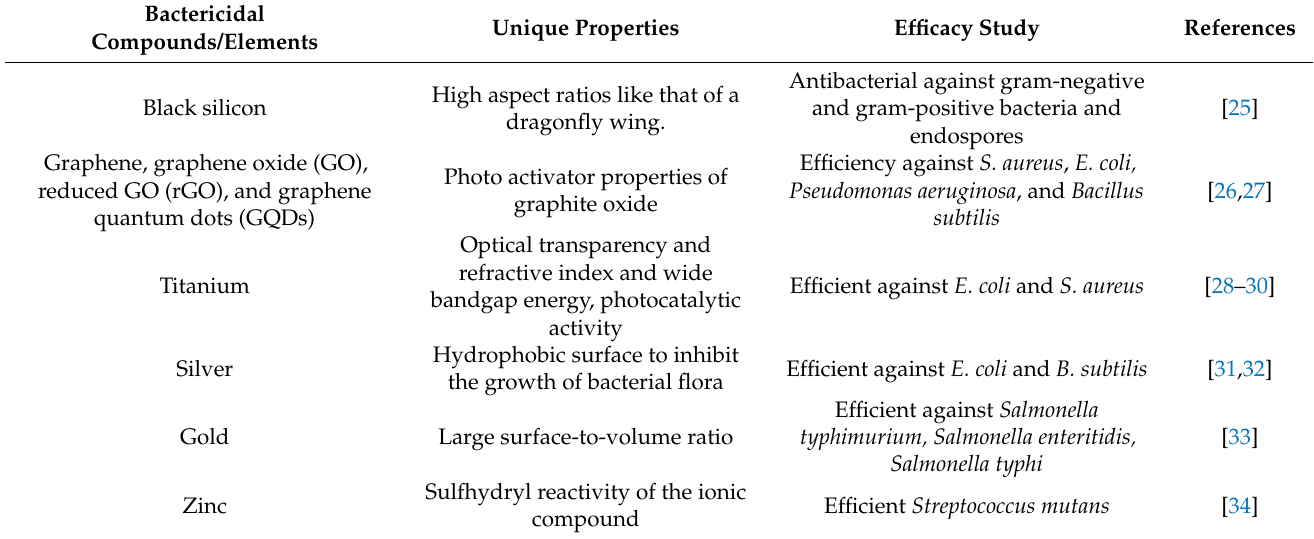
Table 2. Synthetic bactericidal compounds/elements used in developing antimicrobial